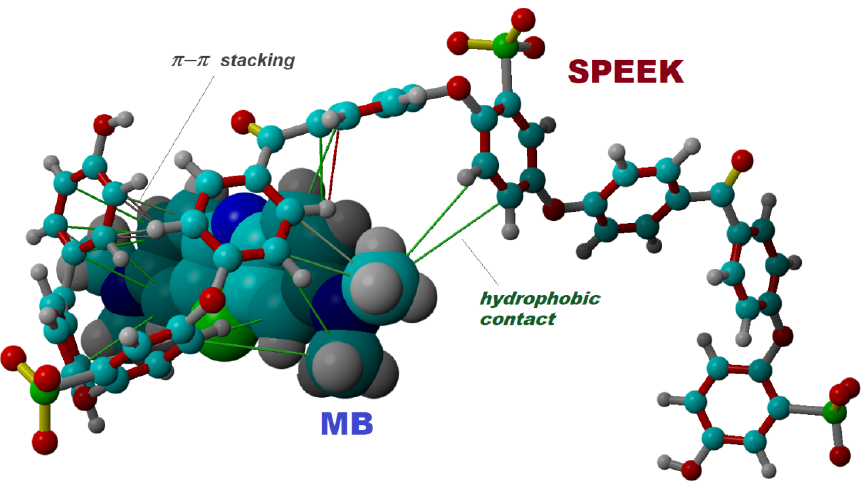
Figure 9. Molecular docking outcome: best pose of the docked complex showing the binding mode and interactions between SPEEK oligomer (receptor) and MB molecule (ligand). and interactions between SPEEK oligomer (receptor) and MB molecule